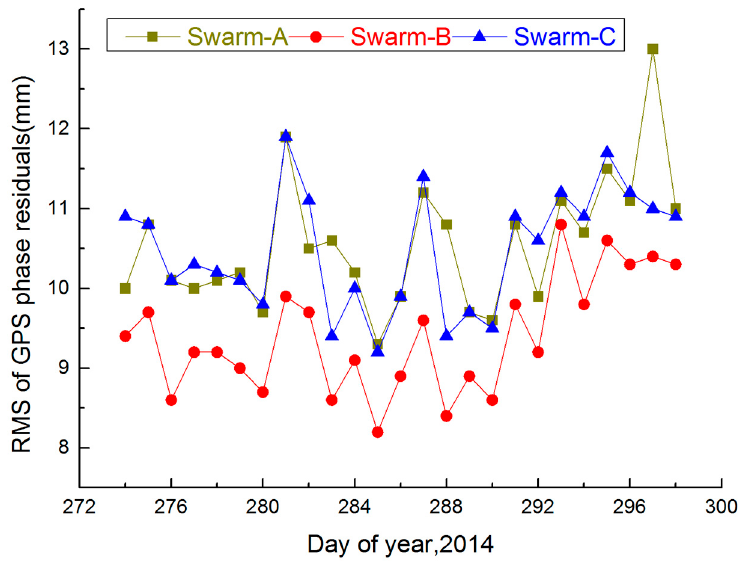
Figure 7. RMS values of GPS phase residuals for Swarm-A, Swarm-B and Swarm-C during day of year (DOY) 274–298, 2014. Table 2. Mean RMS values of GPS phase residuals for Swarm-A, Swarm-B and Swarm-C during DOY 274–298, 2014